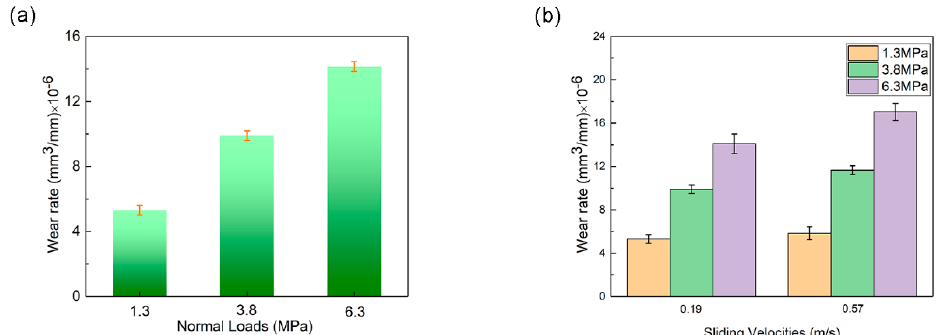
Figure 7. Wear rates of AlSi5Cu1Mg + 0.6 wt % La alloy variation ( a ) at the sliding velocity of 0.19 m/s versus the normal loads; ( b ) under the normal loads of 1.3, 3.8, 6.3 MPa versus the sliding velocity.